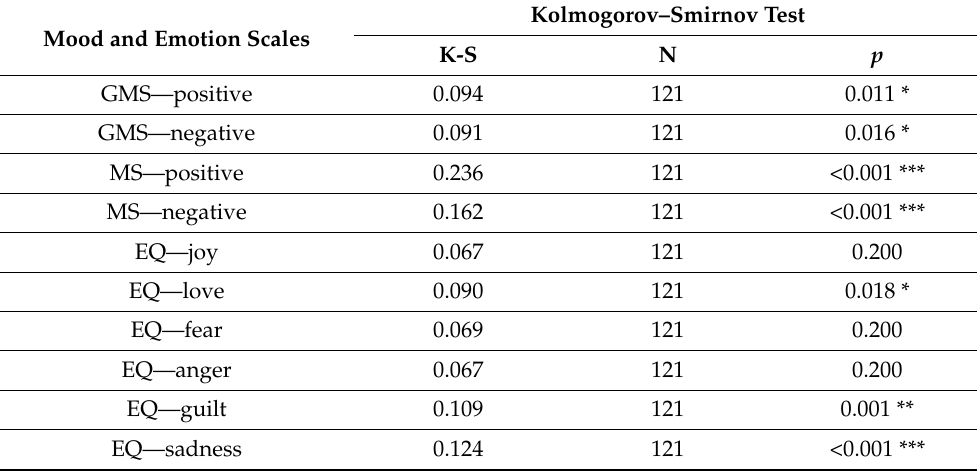
Table 1. Tests of the normality of the distributions of variables concerning the mood and emotion scales. Mood and Emotion